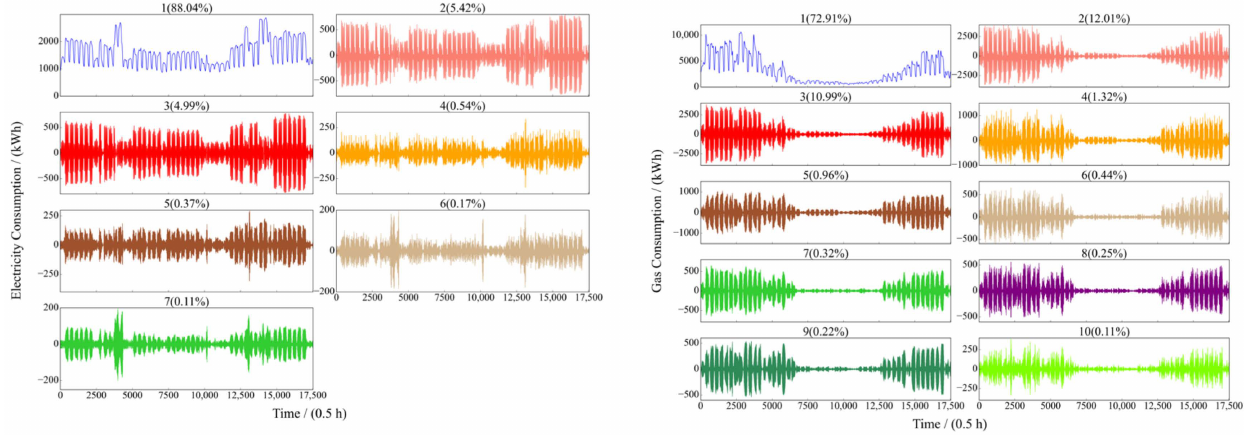
Figure 6. The first seven subsequences of power consumption and the first ten subsequences of natural gas consumption after SSA